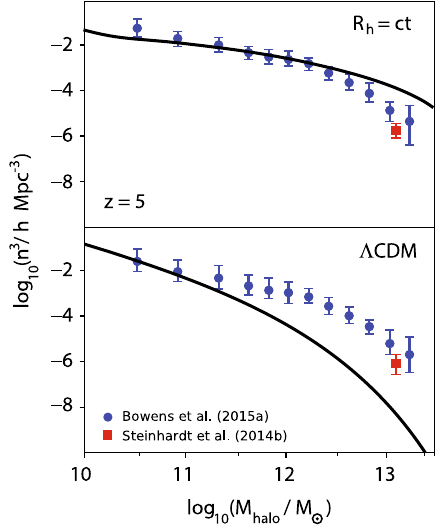
Fig. 2 Top: halo mass function inferred from galaxy surveys at z = 5 compared with R h = ct . Bottom: same, except now for Λ